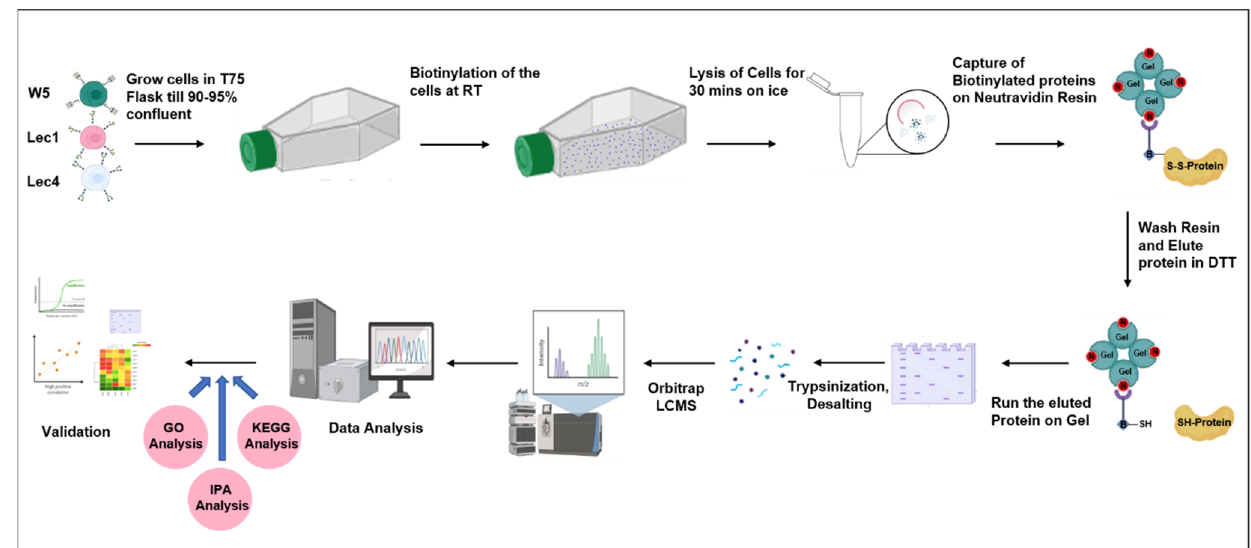
Figure 1. Workflow representation of the analysis of W5, Lec1, and Lec4 cells to identify cell surface proteins, run on HR–LCMS.